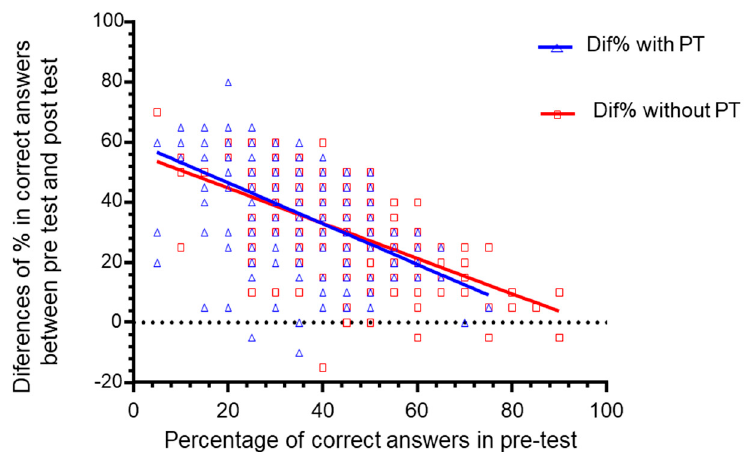
Figure 4. Evolution trend of the difference in the proportion of correct answers between pre-test and post-test. Pearson coefficient r = − 0.5203 (IC 95% = − 0.6076 to − 0.4205) for those with previous training (PT) and r = − 0.6043 to 0.5043) for those without PT, both statistically significant ( p < 0.001), Comparison of correlation (Coefficient of the groups with and without training (Z = 1.2467). The dotted line of the zero value discriminates against those who performed positively, those who did not improve and/or worsen knowledge